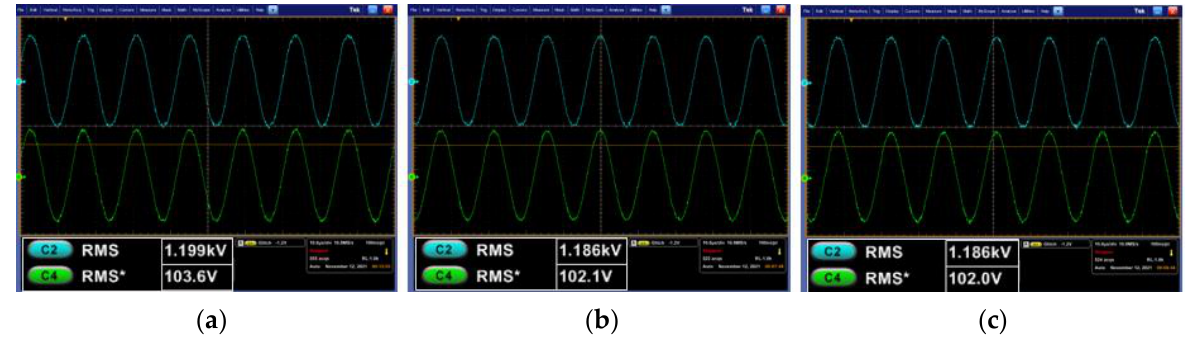
Figure 12. The output voltage of the power transmitting and receiving coil. ( a ) without a detection coil array, ( b ) with a detection coil array, and ( c ) with a detection coil array to which power is sup- plied.